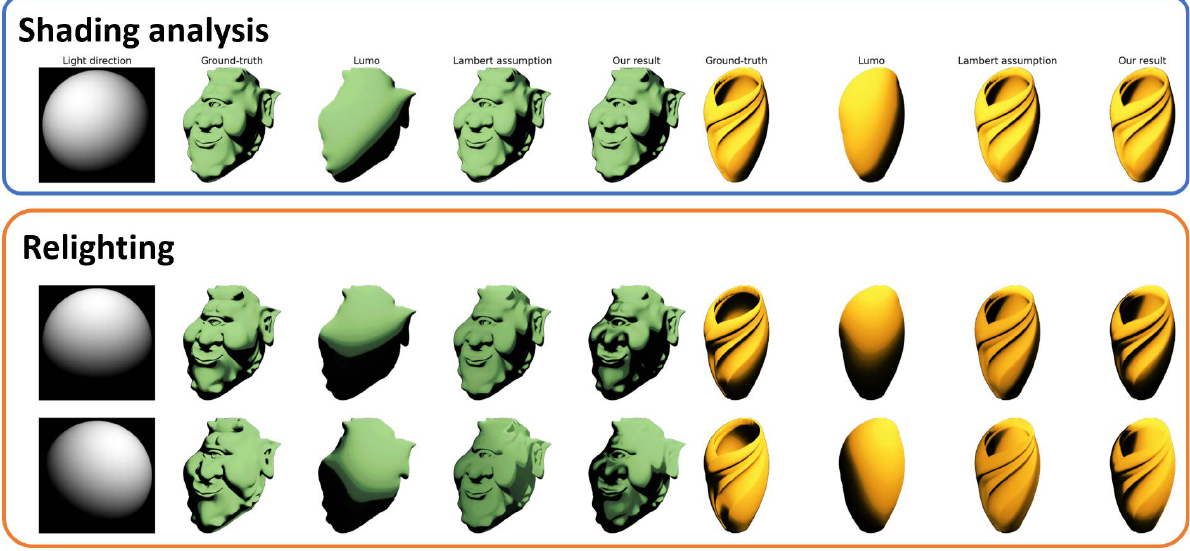
Fig. 16 Comparison of our relighting results with those from Lumo [12] and using the Lambertian assumption in Ref. [4]. The shading analysis shows the estimated shading results from the input ground-truth light direction and shading. The analysis data are used to produce the following relighting results. Our method can produce dynamic illumination changes from the input light directions as in Lumo, which are less noticeable in the Lambertian assumption. The details of the shapes are also preserved in our method.